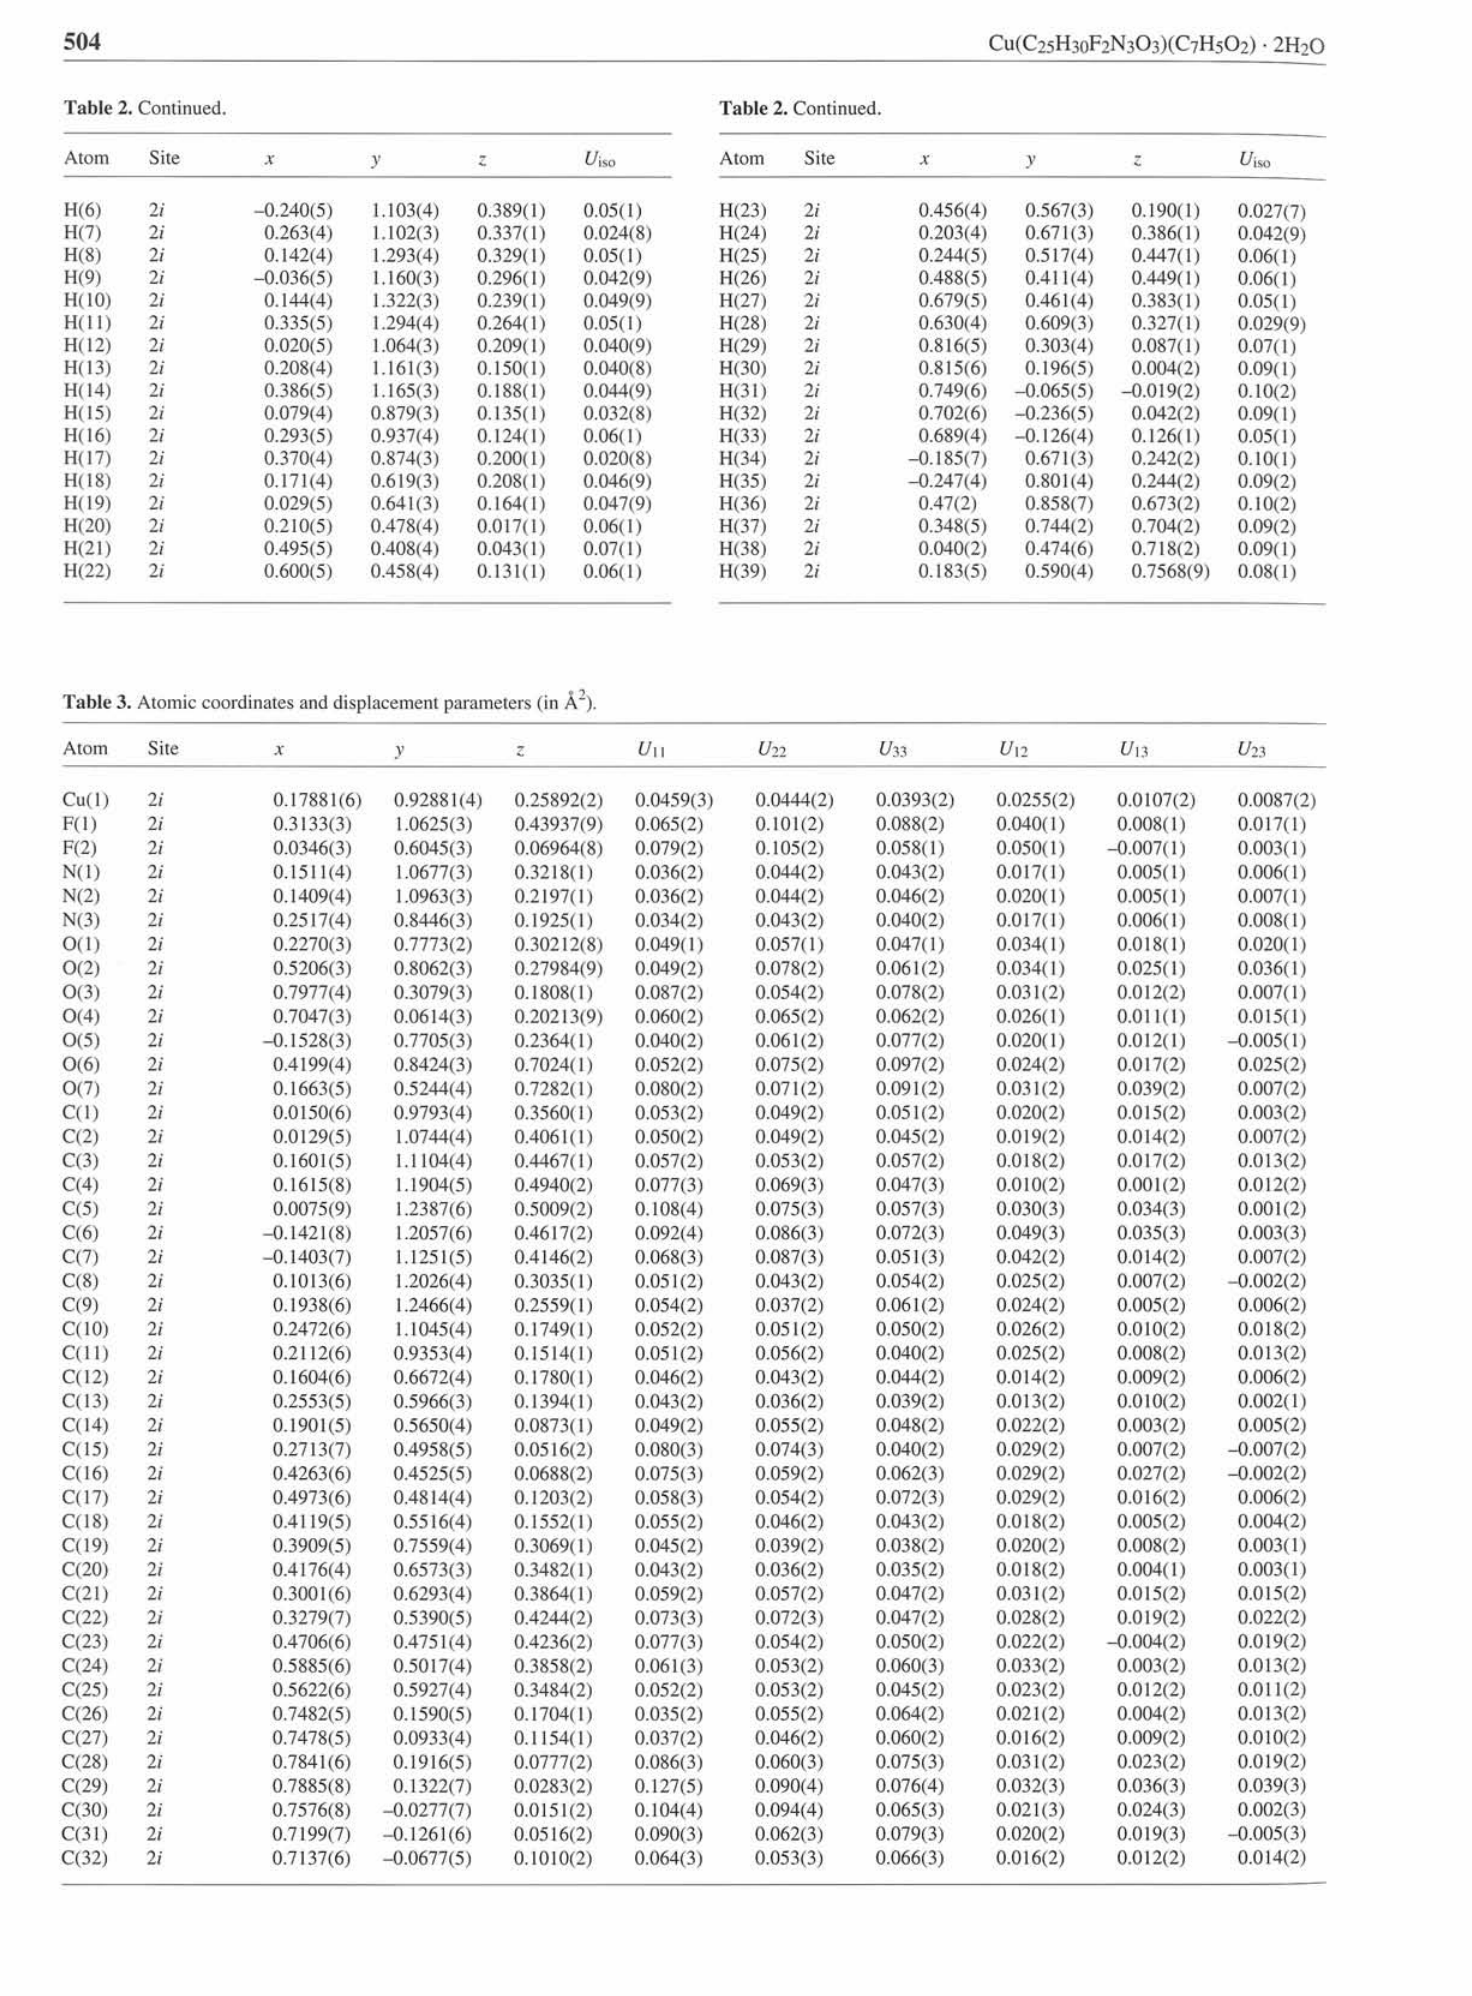
Table 3. Atomic coordinates and displacement parameters (in Â 2